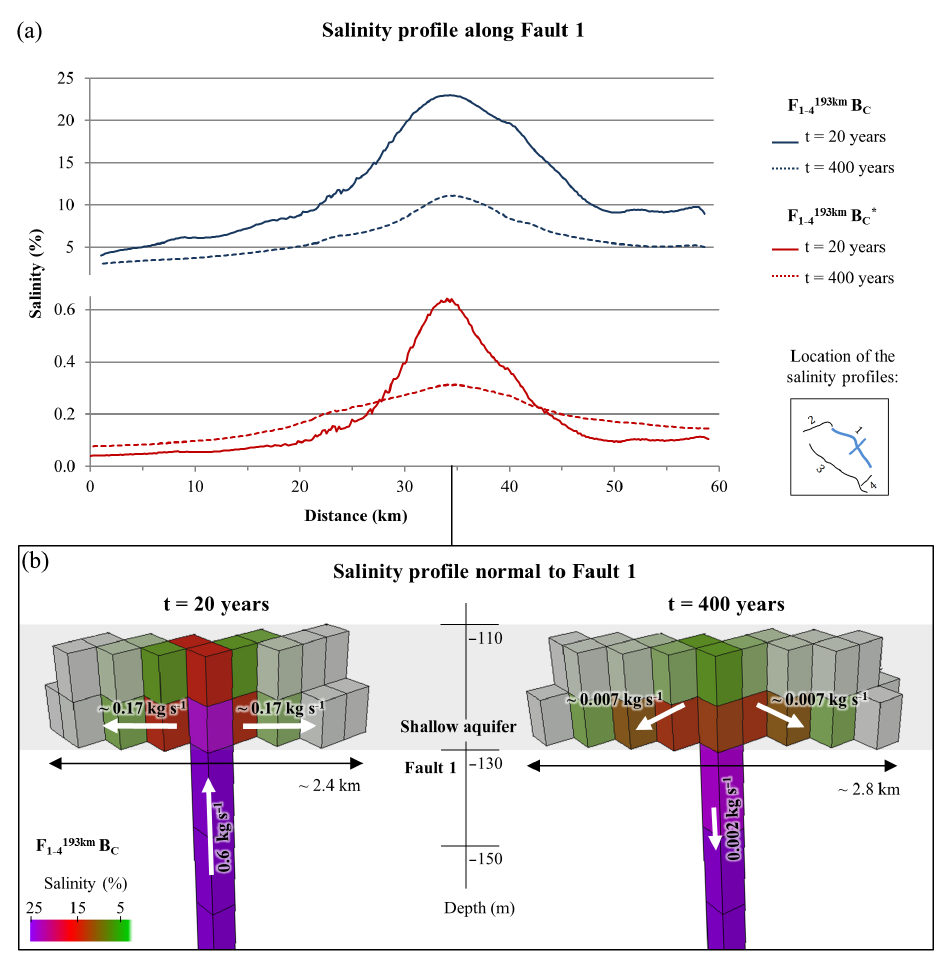
Figure 4. (a) Profile along Fault 1 shows the highest salinities in the central part of the fault near the injection well. Maximum salinities are B ∗ significantly lower, if a salinity gradient is assumed (solid red line; Scenario F 193km ; y axis is not to scale). A decrease in salinisation 1 − 4 C due to a downward flow is observed for the time after the injection period and under the assumption of a sharp saltwater–freshwater interface B C ) . (b) Cross section normal to Fault 1 illustrates the propagation of the saltwater plume in the shallow (dashed blue line; Scenario F 193km 1 − 4 aquifer (salinities >0.05%), while higher salinities can be observed within the lower element layer. White arrows illustrate schematically the direction of fluid flow at 20 years and 400